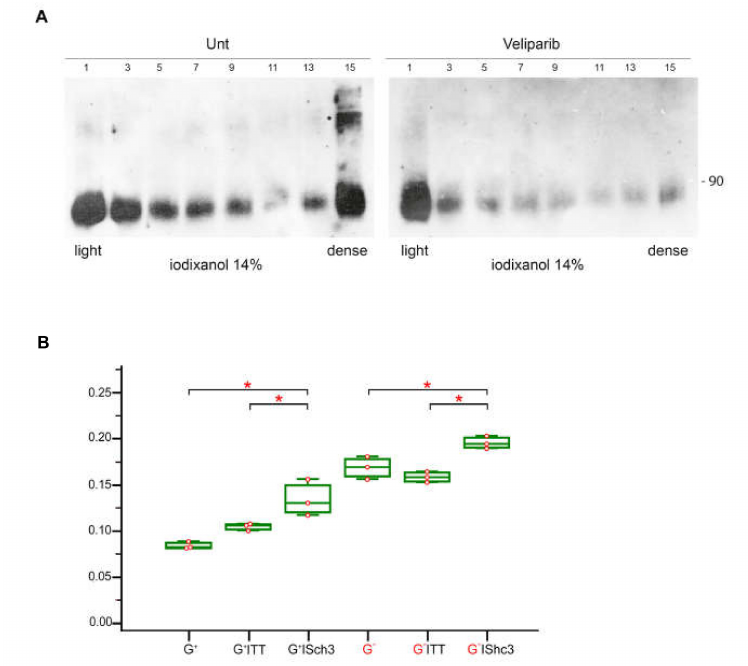
Figure 7. VeliparibinducesareductionofGLUTscofractionatedwithSHC3in vivoandimmunodepletion of SHC3 decreases the inhibitory activity of cytosol of Hu197 cells on PARP1 activity in vitro. ( A ) Western blot using lysates of U-87 MG cells expressing a Glut4 / GFP fusion protein, after fractionation on self-generated iodixanol gradient. In these cells, treatment with Veliparib induces a reduction in the level of the glycosylated Glut4 / GFP (*) in the fractions of the self-generated 14% iodixanol gradient that contain both SHC3 and PARP1. ( B ) Box and whisker plot showing the e ff ect of cytosol purified from Hu197 cells on the in vitro enzymatic activity of purified PARP1. Cytosols were extracted from Hu197 cells maintained as described in Figure 1D. G + : glucose changed every day; G + ITT: glucose changed every day, cytosol immunoprecipitated with antibody against tetanus toxin; G − : glucose exhausted medium; G − ITT: glucose exhausted medium, cytosol immunoprecipitated with antibody against tetanus toxin; G - ISHC3: glucose exhausted medium, cytosol immunoprecipitated with antibody against SHC3. Box represents values from the lower to the upper quartiles; middle line: median; vertical line connects minimum to maximum values excluding outliers; red circles: experimental points. Red * indicate significant di ff erence (one-way ANOVA F-ratio 47.048, P <